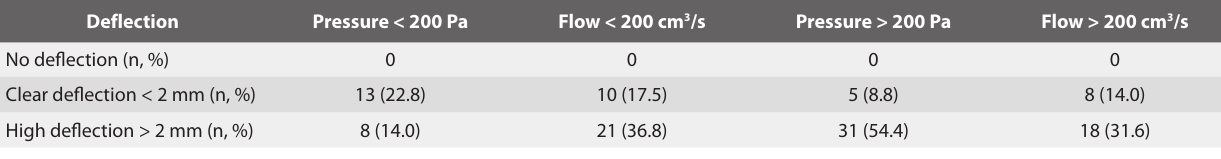
Table 1. Simultaneous measurements of flow, differential pressure, and deflection of the lateral nasal